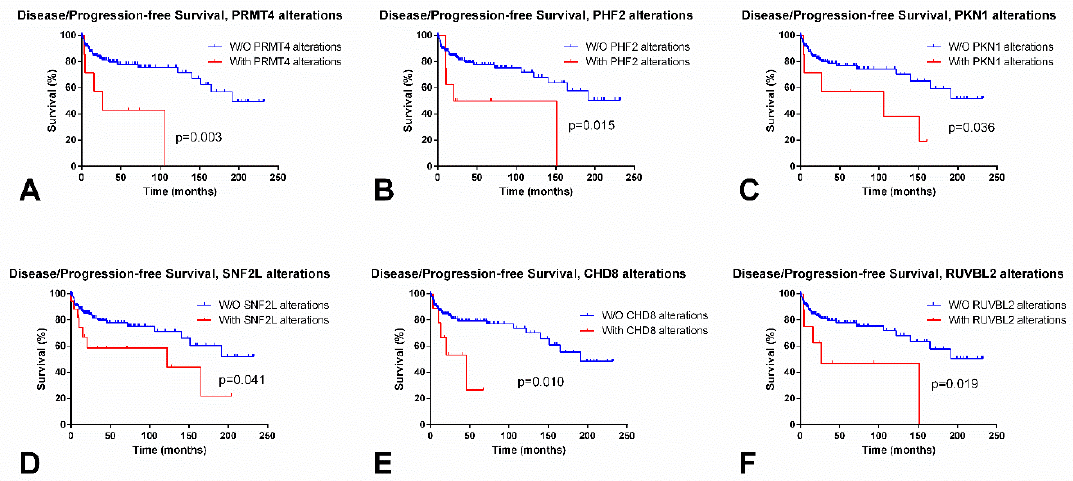
Figure 2. Most significant differences in disease/progression-free survival according to alterations in epigenetic enzymes in testicular germ cell tumors, based on TCGA data. ( A ) Disease/progression-free (D/PFS) according to alterations in PRMT4; ( B ) D/PFS according to alterations in PHF2; ( C ) D/PFS according to alterations in PKN1; ( D ) D/PFS according to alterations in SNF2L; ( E ) D/PFS according to alterations in CHD8; and, ( F ) D/PFS according to alterations in RUVBL2. Lysine Demethylases ( KDMs